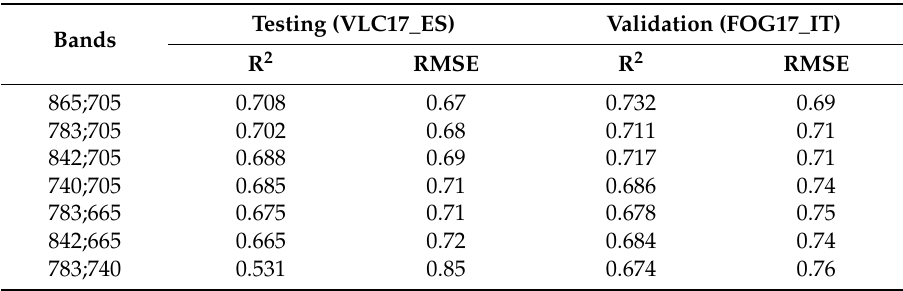
Table 6. Linear cross-validation fitting results of the normalized difference ratio index with different band combinations and LAI green values from the testing and validation datasets, ordered from highest to lowest R 2 according to the testing